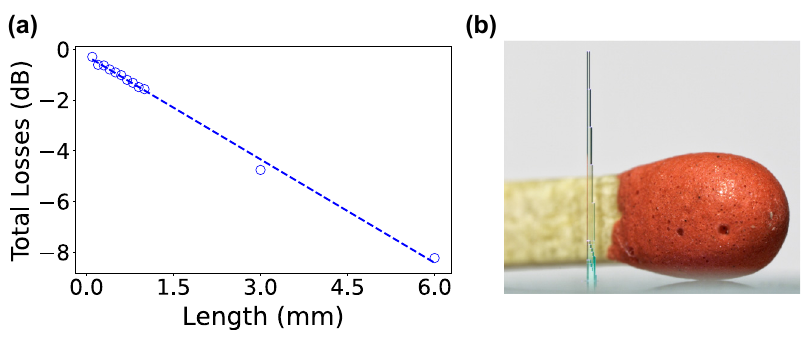
Figure 4: Optical losses and large scale integration. (a) Injection and propagation losses of the fundamental LP 01 mode for d ̃ = 3 . 7 μ m and D =3000mJ/cm 2 UVdose.We fi nd − 0.26dB injection and − 1.36 dB/mm propagation losses. (b) Photography of the structure integrating the 6 mm long waveguide size-scaled to a match.